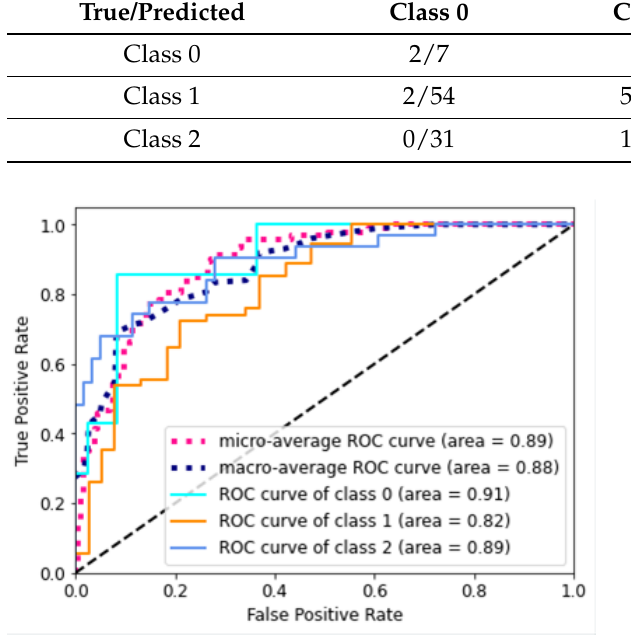
Figure 8. ROC curves for the Microsoft Custom Vision